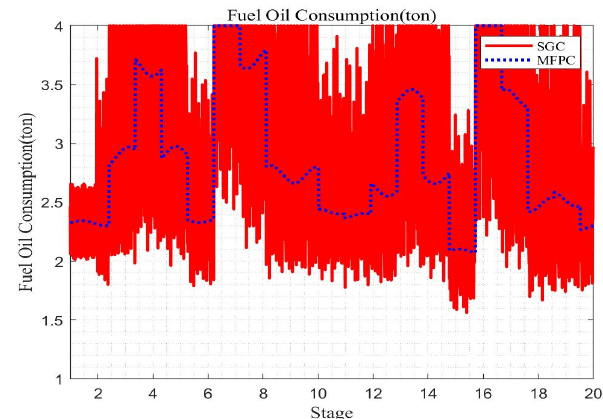
Figure 9. Fuel oil consumption time history according to speed control methods.